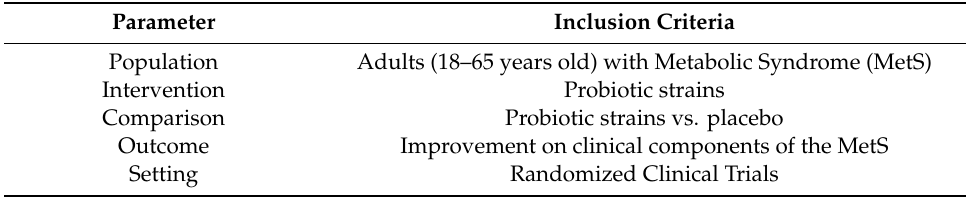
Table 1. PICO (population, intervention, comparison, outcome) criteria for inclusion of